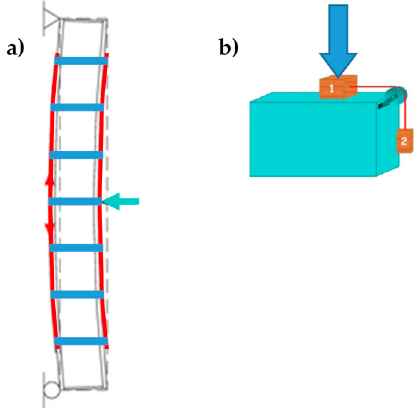
Figure 20. Bending of the CFRP strips tied by the CAM straps: ( a ) the straps counteract the delamination on both sides of the beam. ( b ) At the interface between a CFRP strip (body 1) and the beam (support body), the compression force (blue arrow) provided by a strap to the CFRP strip adds a physical bond that counteracts the sliding of body 1 on the body of support, caused by the sheer force (represented by the action of body 2 on body 1).